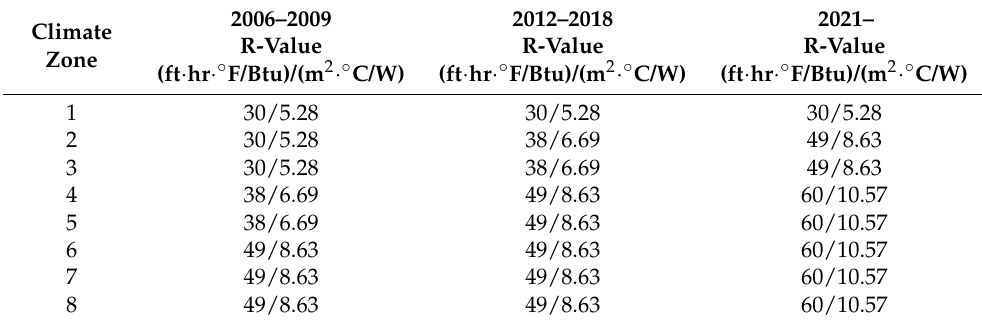
Table 3. Ceiling R-values by climate zone and year required by IECC